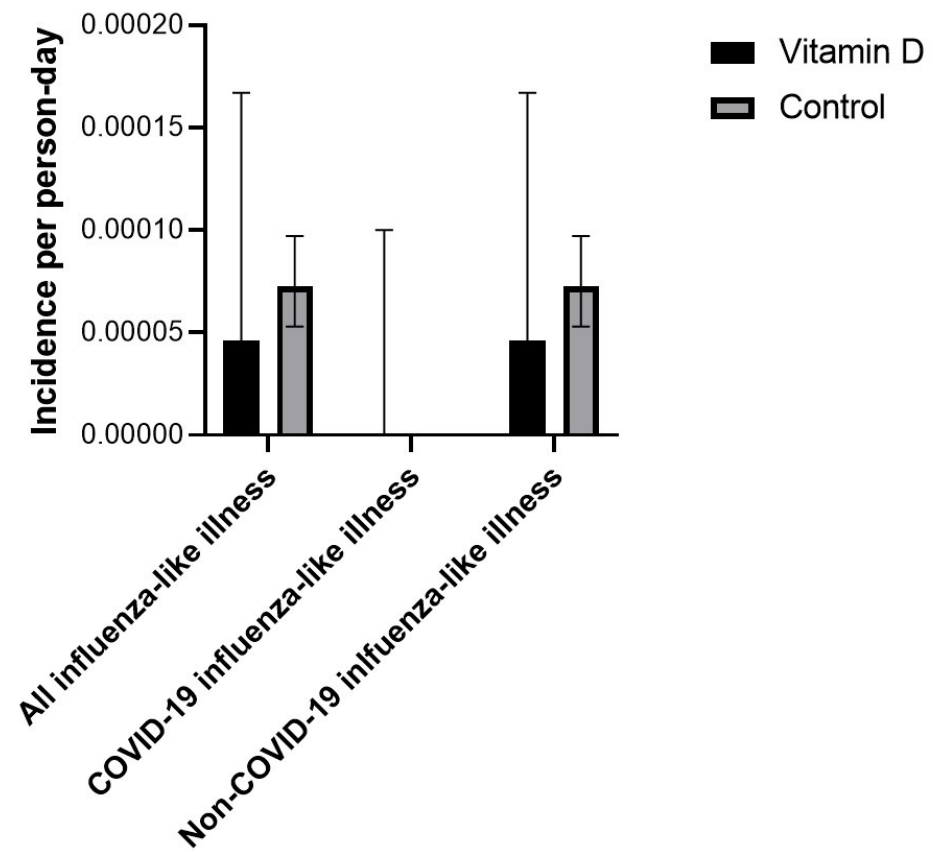
Figure 4. Incidence rate of influenza-like illness, COVID-19, and non-COVID-19 influenza-like illness in the vitamin D supplementation and control groups during COVID-19-vaccinated observation time. 95% confidence intervals are based on the methods described by Sahai and Khurshid [41]. The upper end of the confidence interval is not visible in the figure because it is very close to zero.